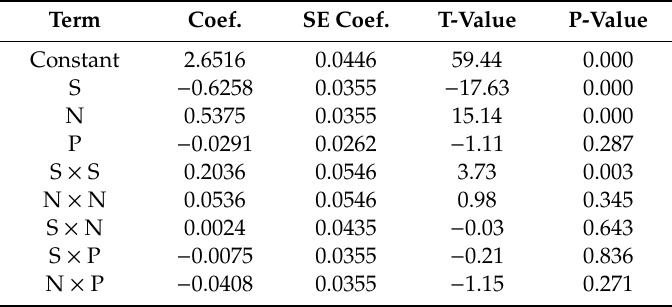
Table 5. ANOVA results for displacements of sample point H in laser-formed saddle-shaped surfaces. Term Coef. SE